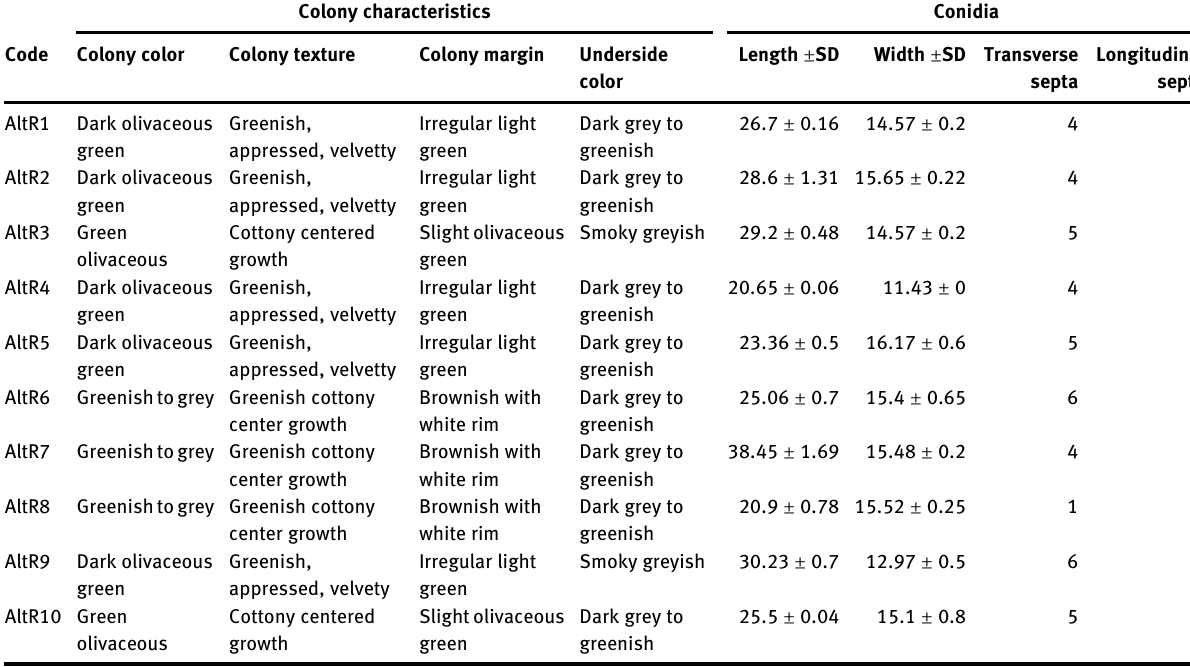
Table  : Alternaria sp. isolate ID with morphological features including colony characteristics (color, texture, margin underside color) and conidia sizes and shapes (length, width, transverse and longitudinal septa) of  isolates of Alternaria